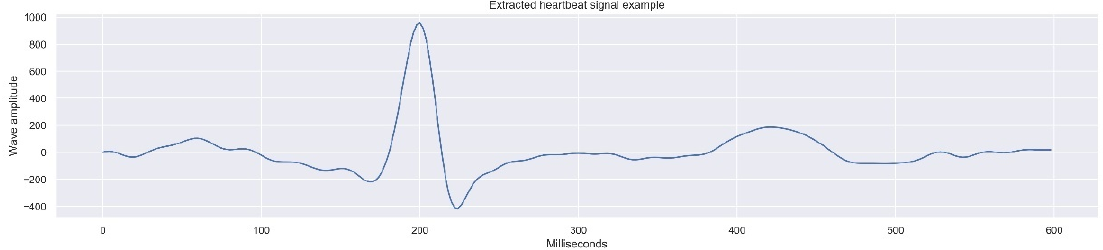
Figure 4. One dimensional data example (heartbeat signal), part of the final